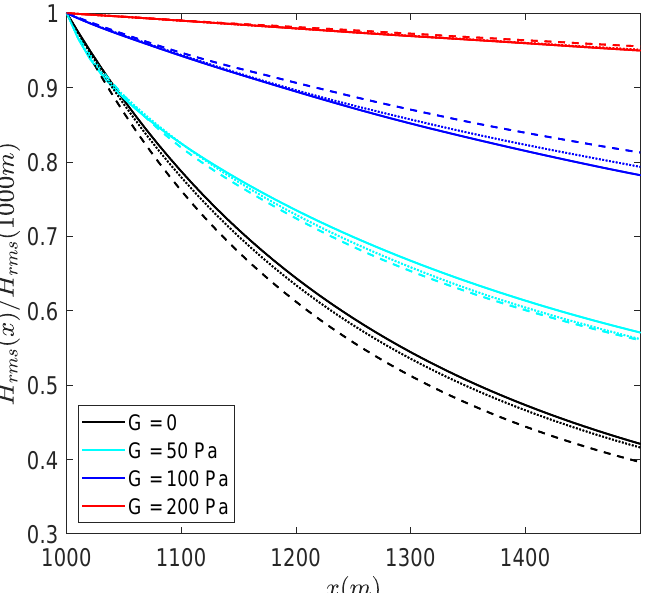
Figure 12. Spatial variation of random wave H rms over viscoelastic mud with shear moduli of G = 0–200 Pa with Fr = +0.15 (solid line), Fr = 0 (dot line), and Fr = − 0.15 (dashed line). Simulation parameters are the same as in Figure 11.